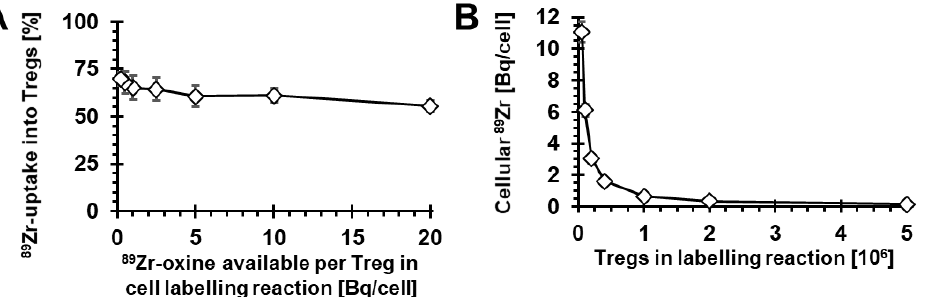
Figure 2. Variation of 89 Zr-oxine-to-Treg cell numbers during radiolabelling. ( A ) The 89 Zr-oxine amount per Treg cell in the labelling reaction had little effect on the fraction of 89 Zr taken up into Tregs. ( B ) Intracellular 89 Zr in Tregs after labelling increased with decreasing Teg numbers in the labelling reaction (concomitant with increasing 89 Zr-oxine-to-Treg ratios). n = 3 and error bars represent SD. Note that total 89 Zr-oxine in the reaction was constant as was Treg concentration in the reaction.